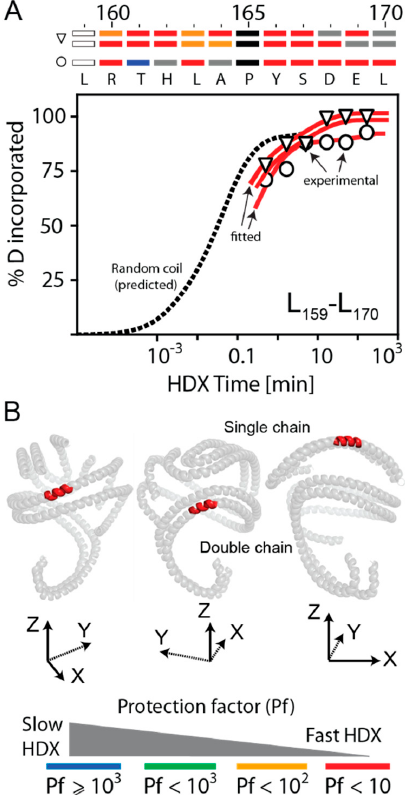
Figure 6. Kinetic curves and HDX residue protection factors for peptide L 159 –L 170 of the Solar Flare region of apoA-I (LCAT binding site) in rsHDL. The experimental DI values were shown with open circles and triangles. ( A ) Time-dependent HDX behavior of peptide L 159 –L 170 . This peptide exhibited bimodal and biphasic HDX kinetics, and both exchange modes (single and double red curves) were rather fast (Supplementary Table 1). The protection factors (Pf) of the residues in L 159 –L 170 for all three chains were shown in the bar chart at the top of the graph; residues with undetermined HDX behavior were colored grey. Most of the residues in this peptide, corresponding to half of the Solar Flare region of apoA-I, were exchanging fast (colored red in the bar map shown on top of the HDX kinetic graph). ( B ) Location of the apoA-I domain L 159 –L 170 in the three apoA-I molecules of rsHDL arranged in the monomer/dimer configuration predicted by the HdHp model. The HDX data showed that this protein domain was rather dynamic (Pf avg < 10) for all apoA-I molecules. Different combinations of non-overlapping digested peptides (Figure 4) could be used to create probable conformations of the three apoA-I chains in rsHDL. As an example (Figure 7), we used the first row of peptides from Figure 4B to construct conformations separately for the apoA-I dimer and the hairpin monomer and mapped the selected peptides to the 3-D models (HdHp, iT3, 3Hp) of rsHDL proposed previously based on SANS [30]. The conformations obtained with this particular set of peptides were overall very dynamic, displaying relatively low protection factors to D incorporation (Pf < 100) for most of the protein chain. The hairpin monomer was more dynamic than